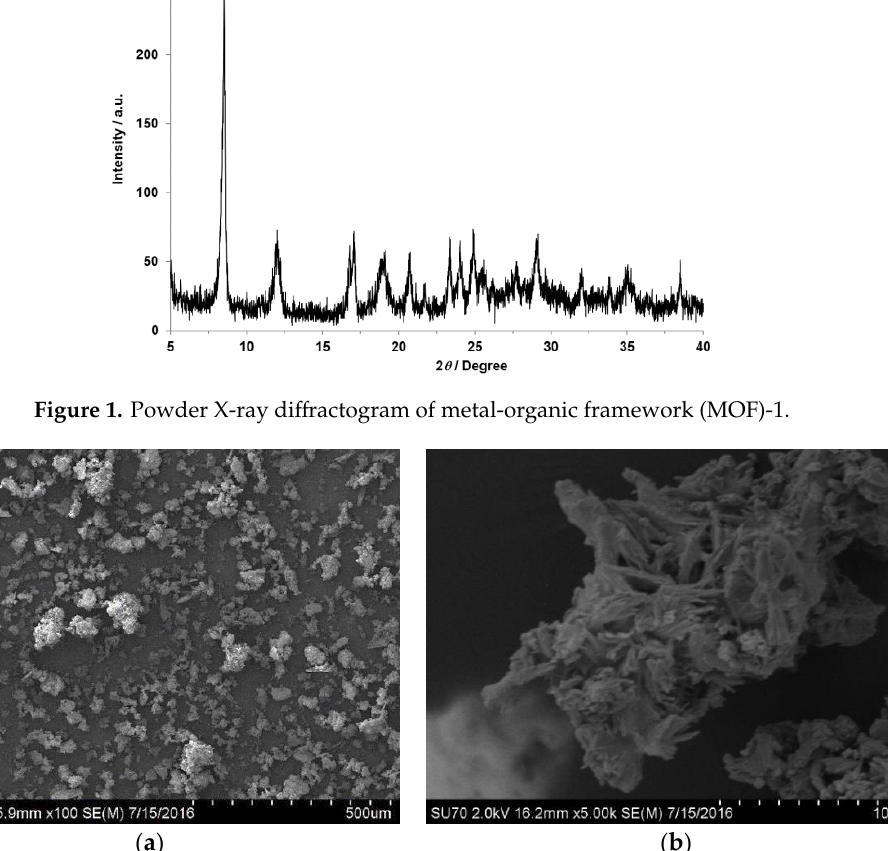
Figure 2. SEM Images of MOF-1. Increasing magnification from 100 × ( a ) to 5000 × ( b ).